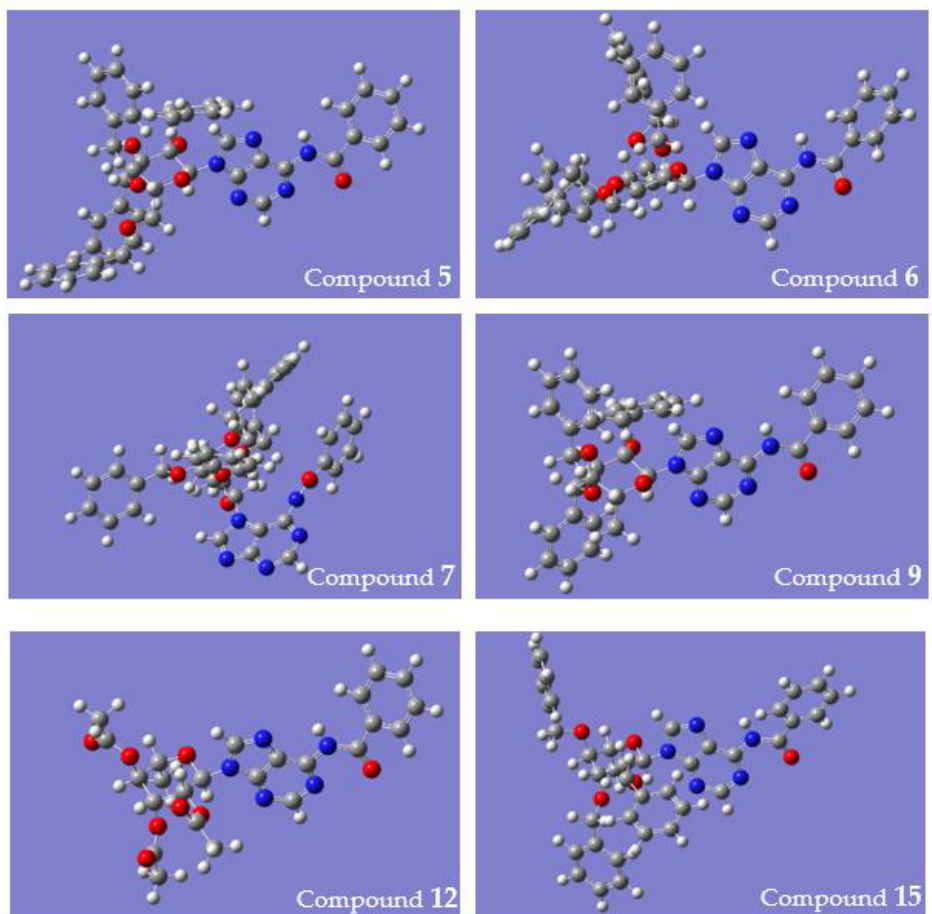
Figure 2. Representation of the final optimized geometries found for compounds 5 , 6 , 7 , 9 , 12, and 15 , deduced in Gaussian16 with CAM-B3LYP/def2TZVP and IEFPCM for water.